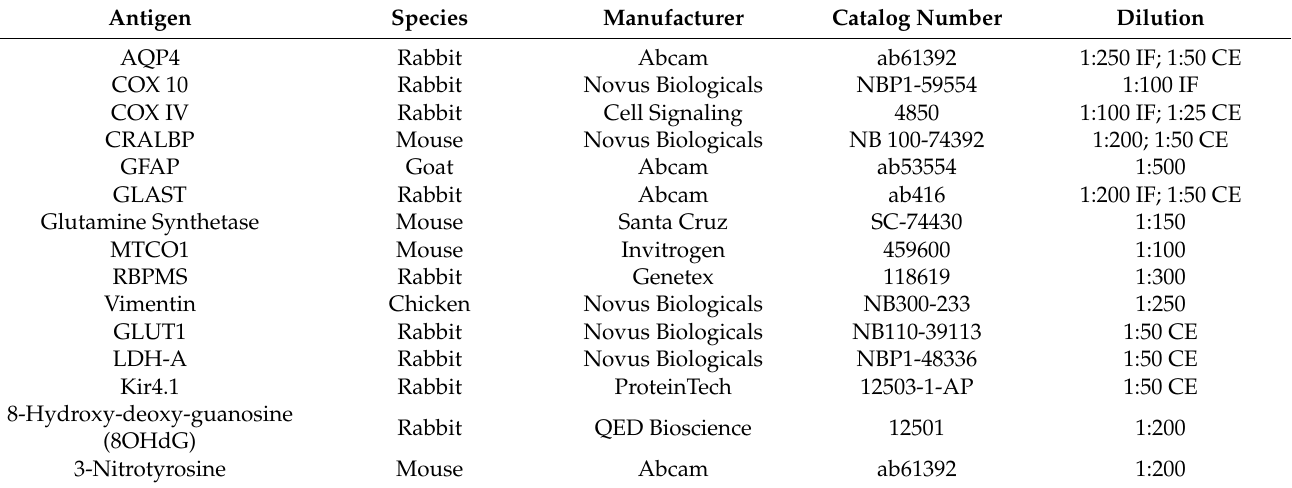
Table 1. Antibodies used in immunofluorescence and capillary